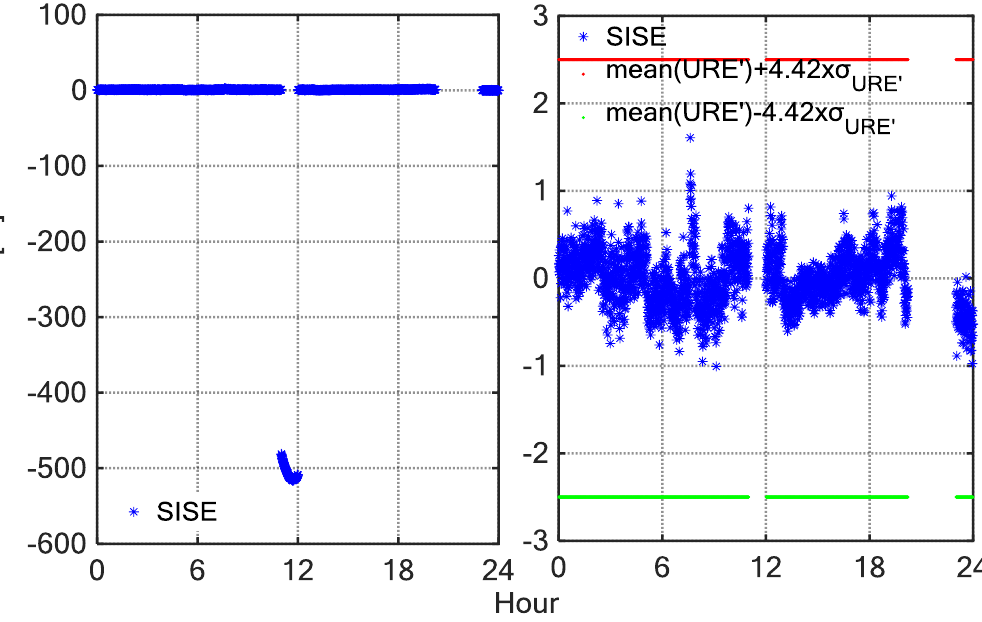
Figure 11. SIS-URE after eliminating the trend term time series as a function of BDT on day 346 of 2015 for BDS satellite C02 tracked by NNOR. Subplot ( left ) corresponds to the tracking data of satellite C02 by NNOR for the whole day, and subplot ( right ) corresponds to the tracking data of satellite C02 by NNOR with the anomalous periods removed.